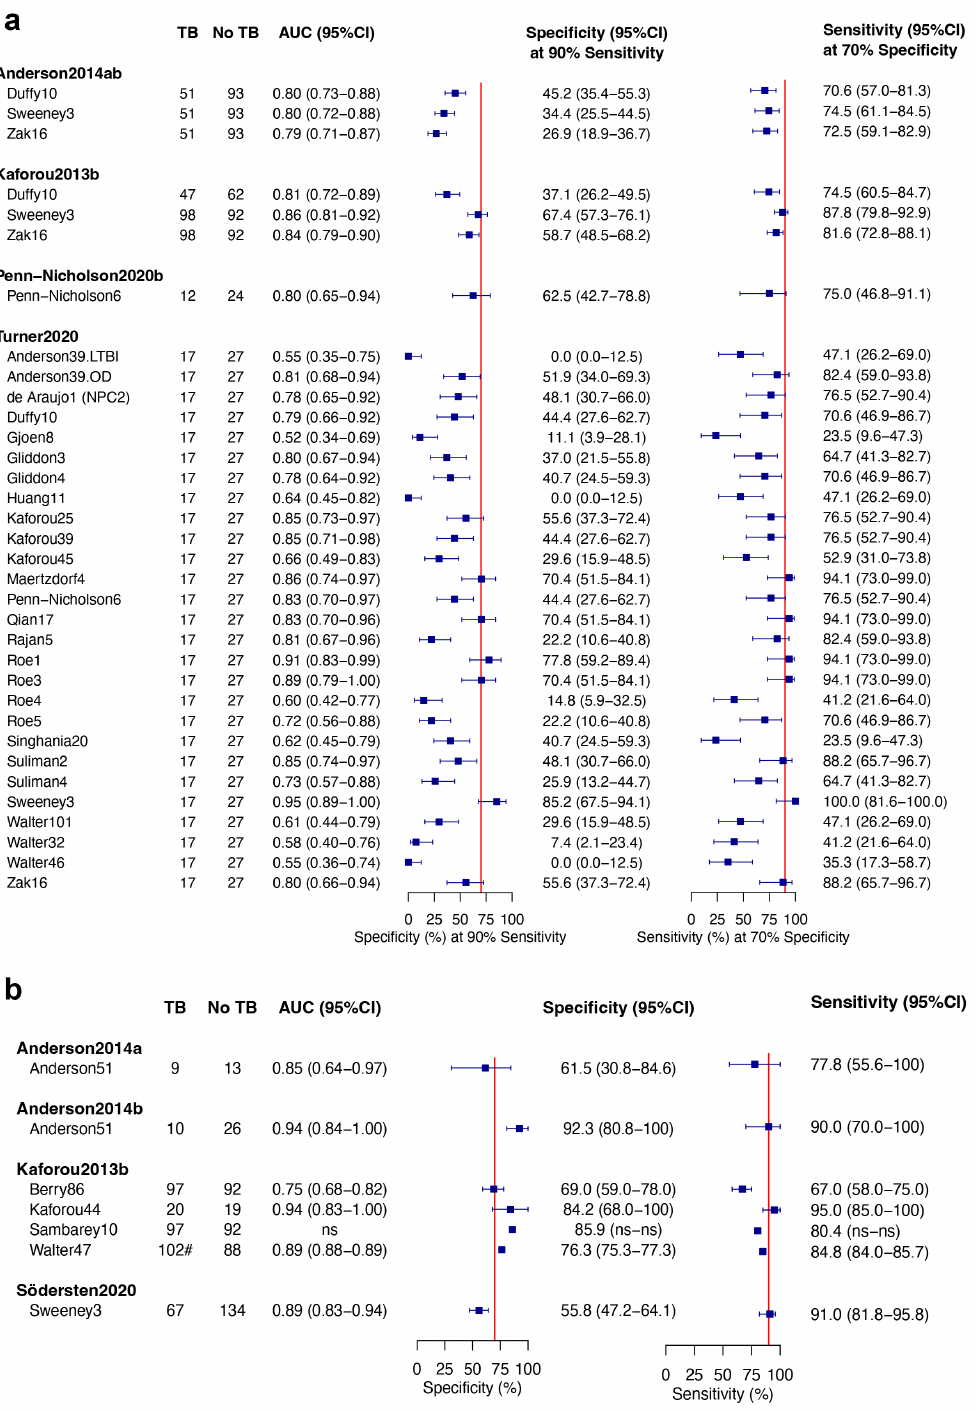
Figure 4. Transcriptomic signature diagnostic performance for differentiation of patients with microbiologically confirmed TB disease from patients with other diseases in independent test or external validation cohorts. ( a ) Signature diagnostic performance (area under the curve, AUC) recalculated using participant-level data retrieved from supplementary data or supplied by study authors, with sensitivity and specificity benchmarked against the WHO TPP minimum performance criteria for a triage test (70% specificity and 90% sensitivity, red vertical lines) 16 . 95% confidence intervals for AUC and proportions (sensitivity and specificity) were calculated using the DeLong 30 and binomial proportion (Wilson) 31 methods, respectively. ( b ) Signature diagnostic performance and 95% confidence intervals as originally reported in studies where participant-level data were not available. # 102 TB cases were reported in the paper by Walter et al. ( J Clin Microbiol, 2016) 39 . however only 97 TB cases were included in the original microarray analysis 37 . ns, not